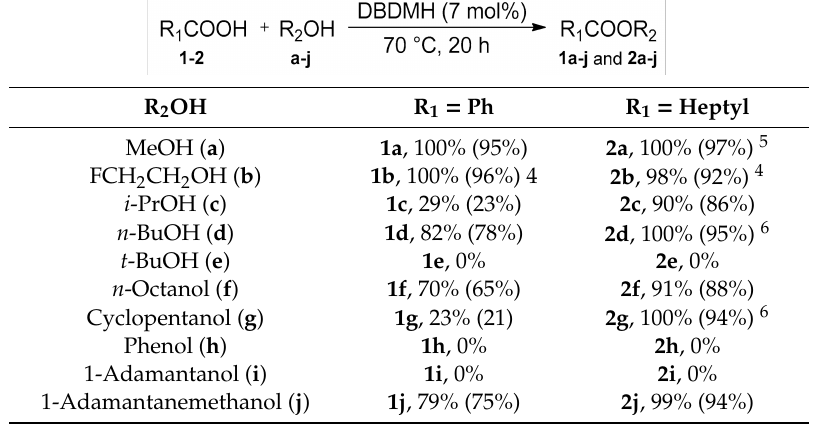
Table 3. The e ff ect of alcohol structure on the esterification of benzoic acid ( 1 ) and octanoic acid ( 2 ) 1,2,3 .